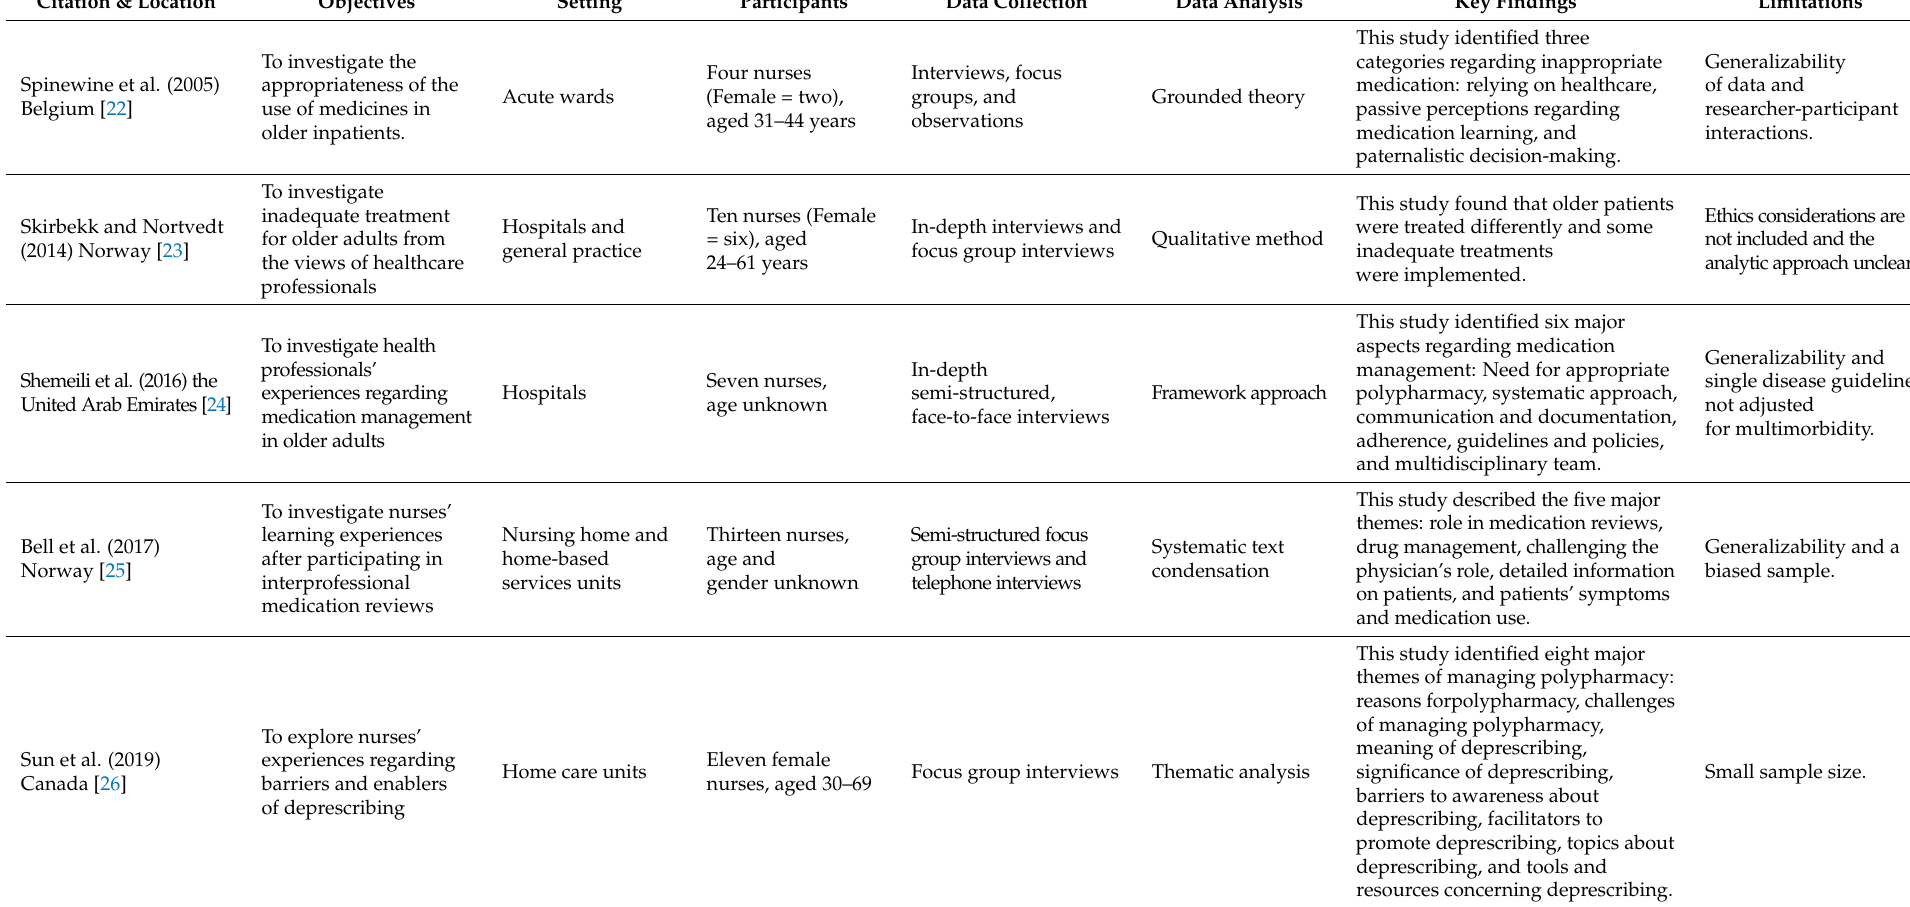
Table 2. Key characteristics of included studies